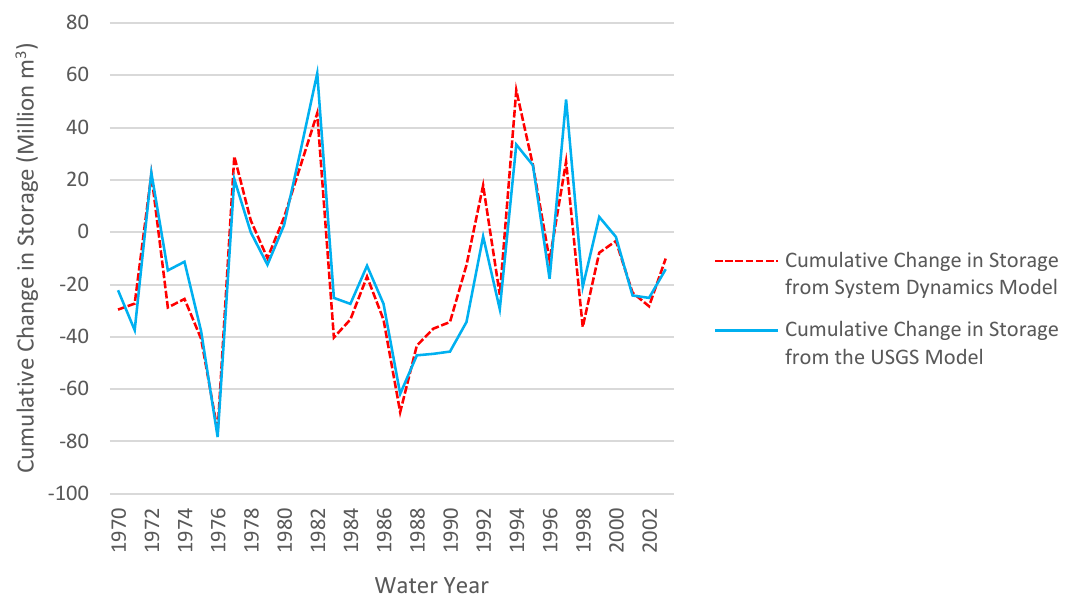
Figure 5. Comparison of cumulative change in storage for the Modesto models.